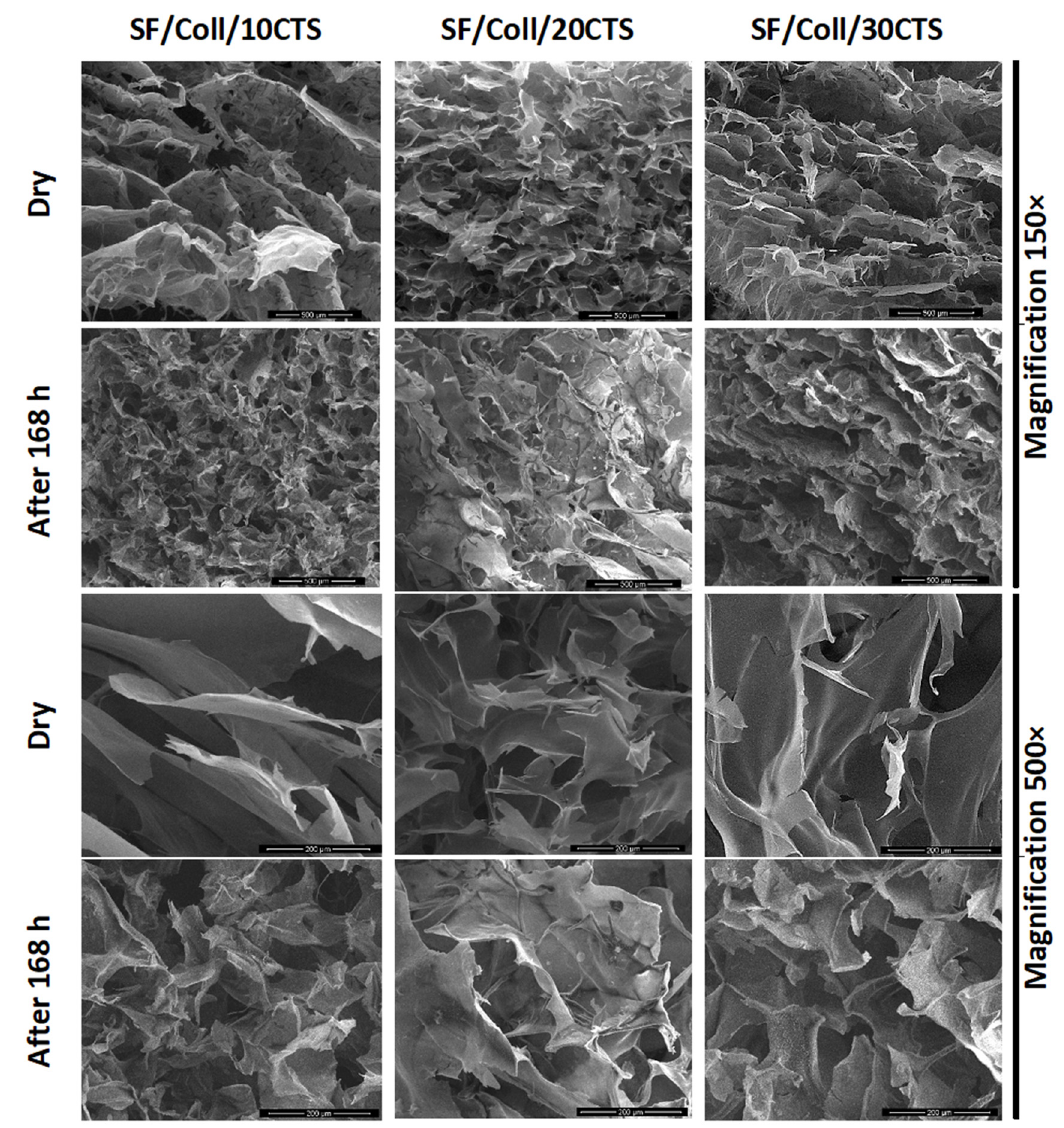
Figure 6. SEM images (magnification 500× and 150×) of SF/Coll mixtures with 10, 20, and 30% CTS (left to right columns) for dry scaffolds and after 168 h of immersion in PBS.